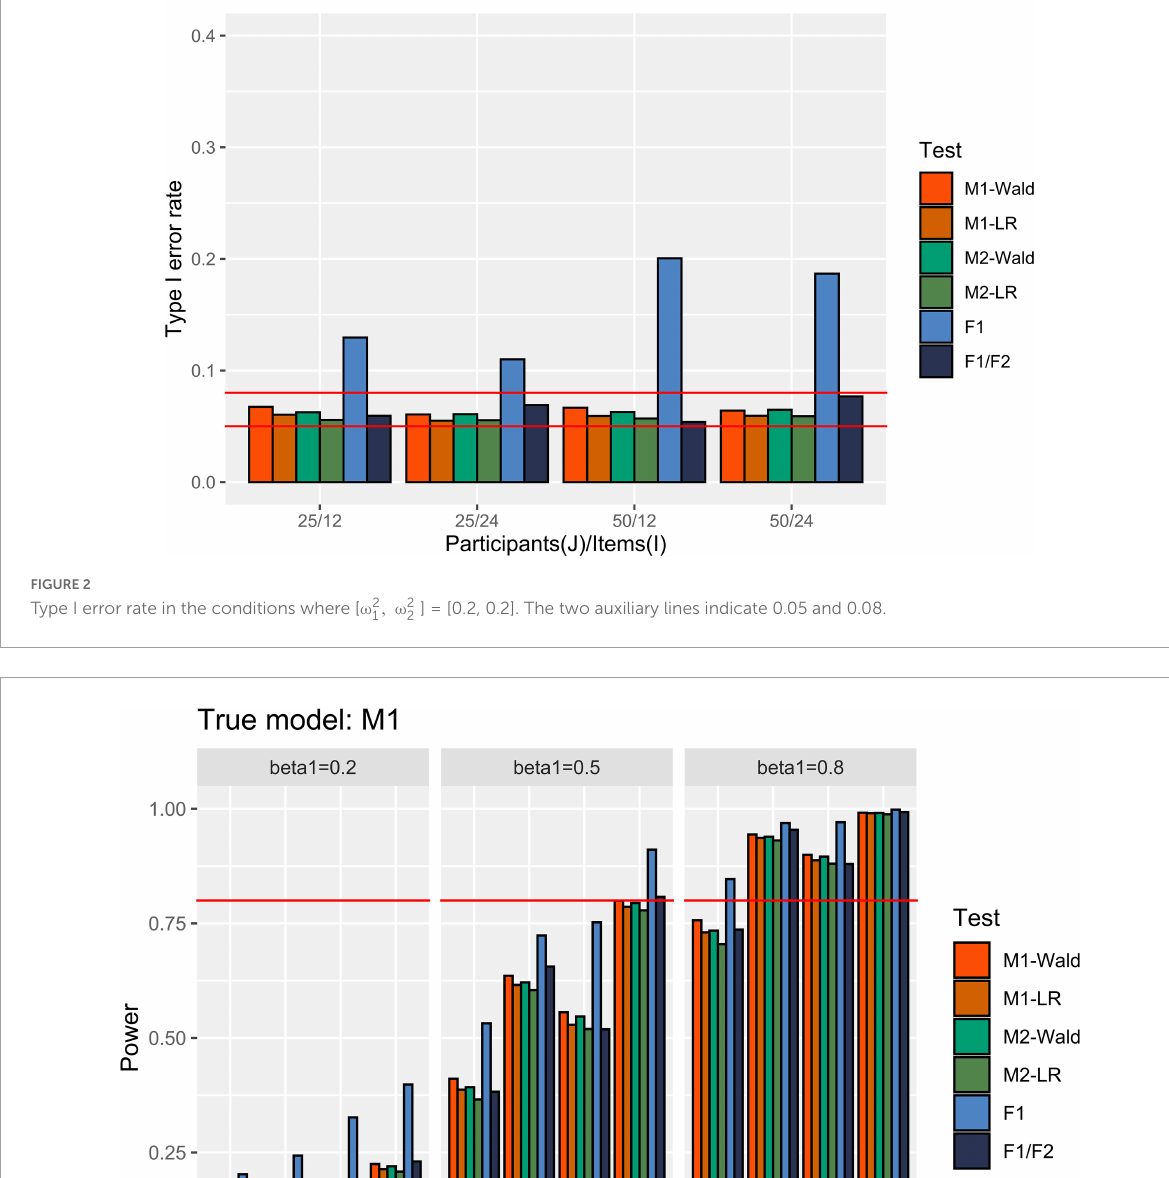
J = 50, I = 12. The F 1/ F 2 test showed an error rate of over 0.08 under the condition where I = 24 and [ ω 2 The F 1 test showed an error rate exceeding 0.15 in all